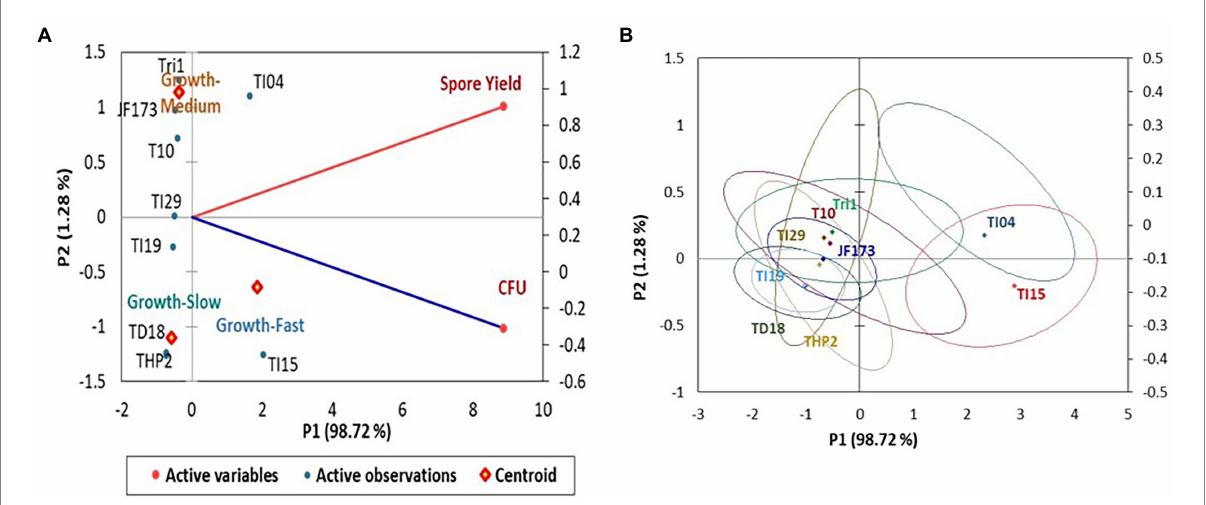
FIGURE 3 PCA plot of the growth pattern of nine Trichoderma isolates under LAISS. (A) A biplot of spore yield and density. (B) Bootstrap ellipses based on spore density and yield.